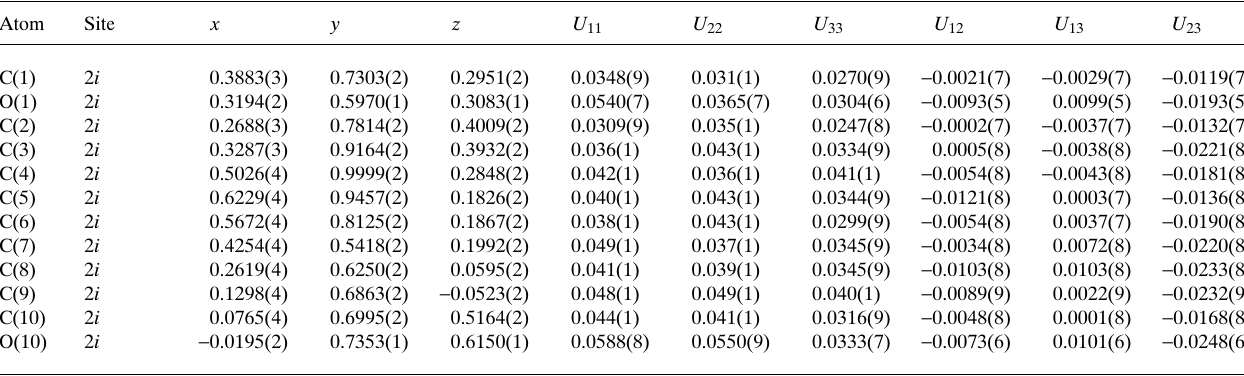
Table 3. Atomic coordinates and displacement parameters (in Å 2 )